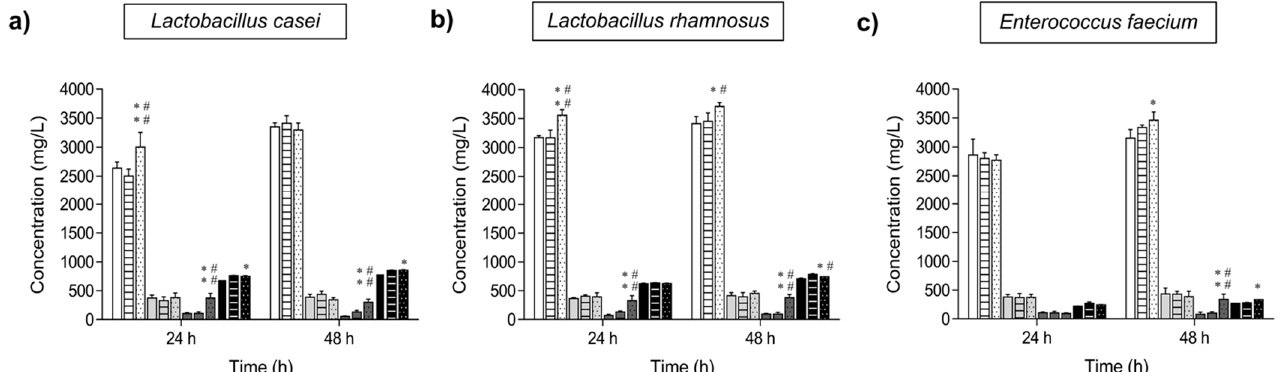
Figure 5. Evolution of the organic acid (SCFA and lactate) production in probiotic bacteria cultures. The concentrations of the organic acids (means ± standard deviation) at 24 and 48 h are indicated for L. casei ( a ), L. rhamnosus ( b ) and E. faecium ( c ) cultures in MRS media without carbon source (empty bars), with the commercial FOS mixture (lined bars) and with isomelezitose (dotted bars). References: acetate (white bars), propionate (grey bars), butyrate (dark grey bars) and lactate (blacks bars). Differences ( p < 0.05) with the negative and positive controls are indicated with (*) and (#), respectively.